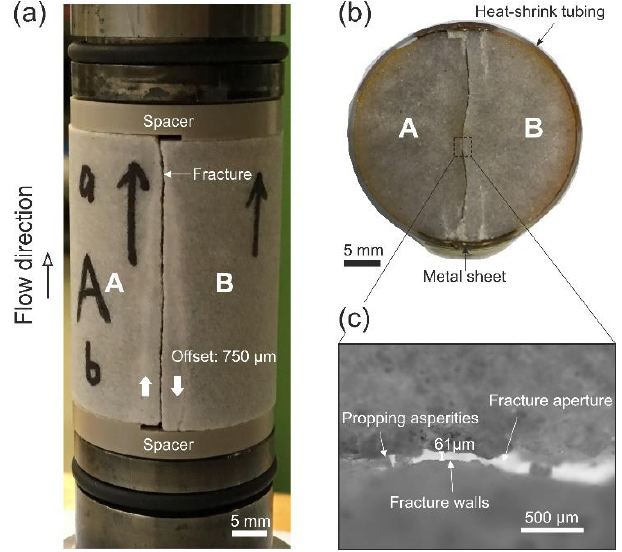
Figure 1. ( a ) The cylindrical rock sample contains a single tensile fracture along its principal axis. ( b ) The assembled sample (view after the experiment) is constrained by heat-shrink tubing and a metal sheet is placed between the fracture edges and the heat-shrink tubing to prevent the latter from punching under confining pressure. ( c ) A magnified image shows a representative microstructure of the fracture aperture (after the experiment), wherein propping asperities keep the fracture open and the free fracture walls are directed toward the void space.